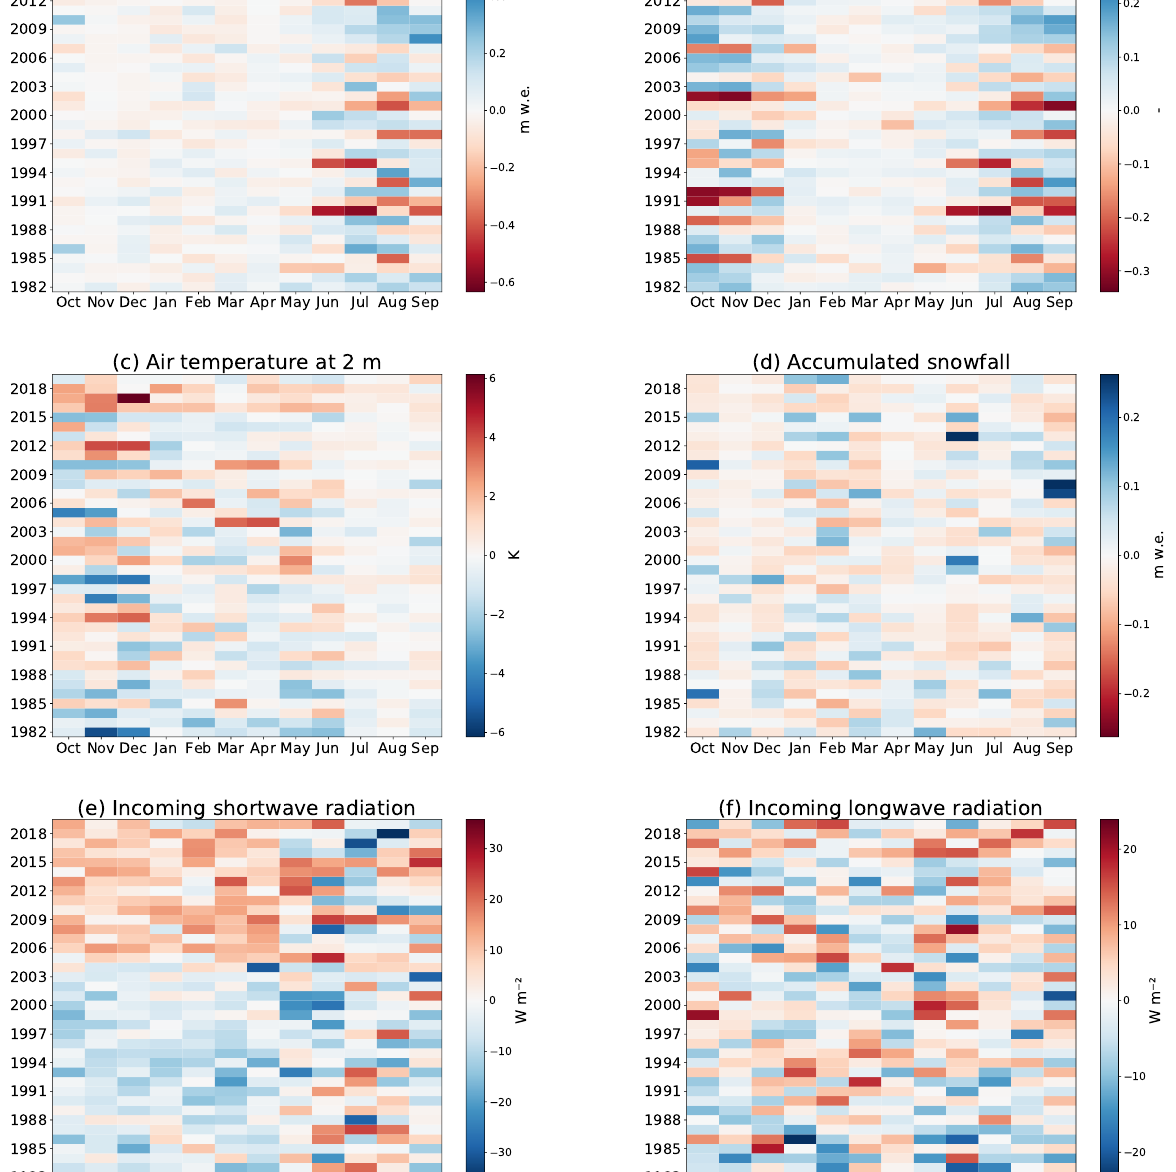
Figure A5. Monthly mean deviations 1982 to 2019 from long-term monthly mean values of glacier-wide climatic mass balance ( a ), albedo ( b ), air temperature at 2m ( c ), accumulated snowfall ( d ), incoming shortwave radiation ( e ) and incoming longwave radiation ( f ). The color bar is arranged so that deviations that act positively (negatively) on glacier-wide climatic mass balance are shown in blue